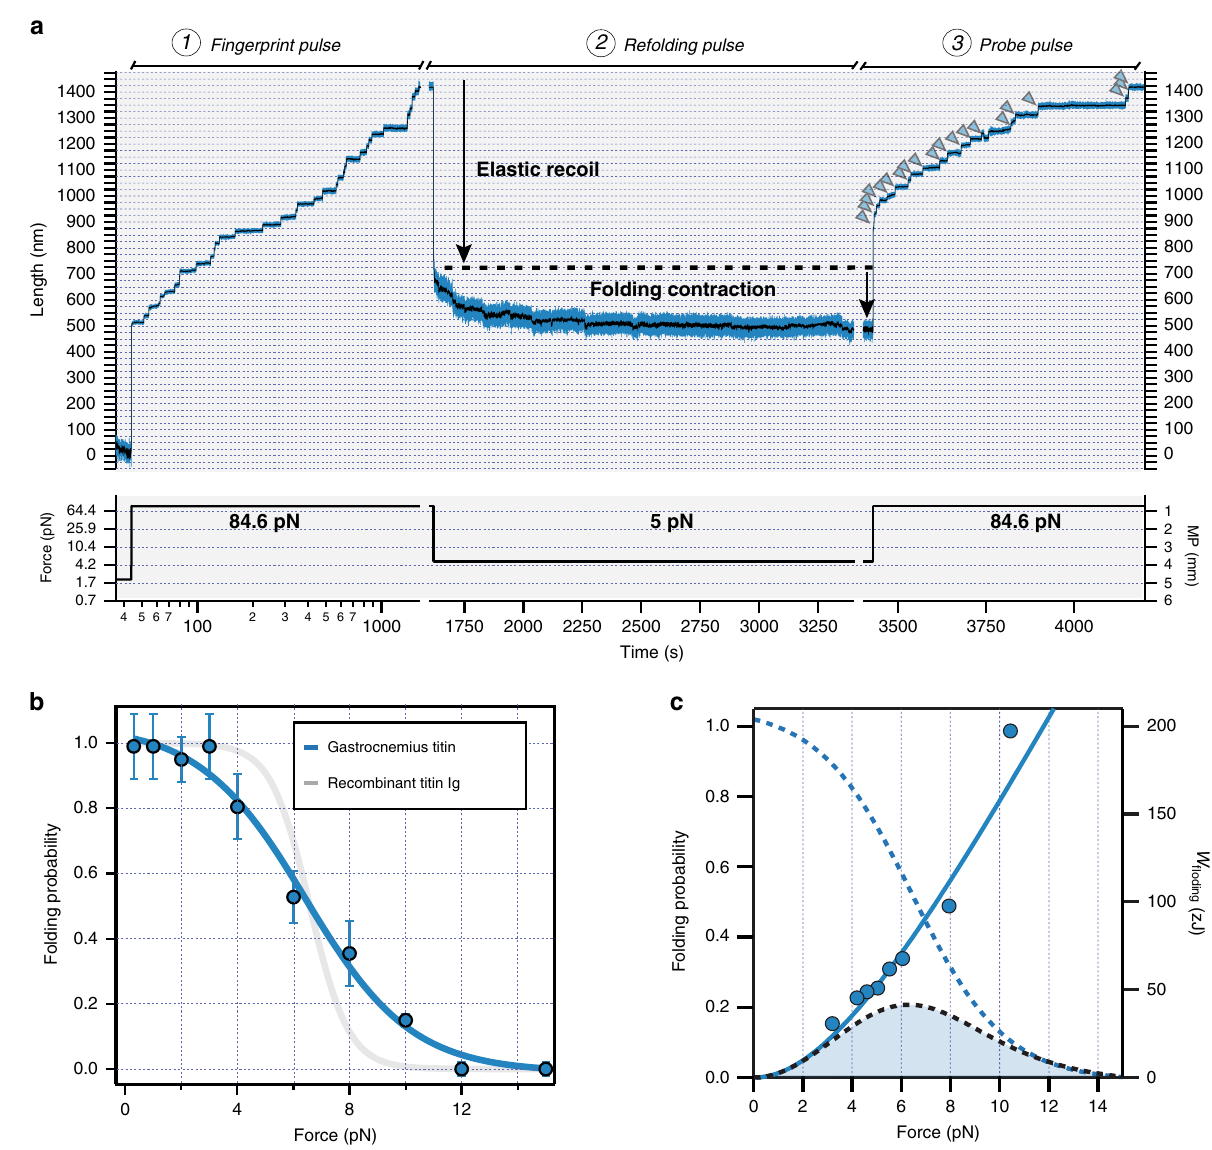
Fig. 4 Mechanical work generated by titin folding. a We follow a three-pulse force protocol. During the fi ngerprint pulse at high forces (1), Ig domains are recruited to the unfolded state. These domains are allowed to refold during the long refolding pulse at low force (2). To estimate folding fractions, we measure the number of domains that unfold in the fi nal probe pulse (3), and compare with the initial number of unfolding domains in the fi ngerprint pulse. Arrowheads point to unfolding events in the probe pulse. The trace was obtained using gastrocnemius HaloTag-TEV titin. b Folding probability of the I- band of HaloTag-TEV titin isolated from gastrocnemius muscle (blue symbols). Solid line shows a sigmoidal fi t to the data. The folding probability is less cooperative that the one obtained with engineered titin polyproteins (in gray, data from Rivas-Pardo et al. 15 ), while the P F0.5 remains very similar. Data are presented as mean values ± SD, n = 120 total measurements. Source data are provided as a Source Data fi le. c Force dependency of the work delivered by titin domain folding, which is obtained by multiplying step sizes by force (blue symbols). The solid line considers the step sizes obtained by the worm-like chain model. Considering the probability of folding (blue dashed line, data from panel b ), we calculate the expected work delivered by titin folding (black dashed line, fi lled area), which peaks at 6.3 pN producing 41.5